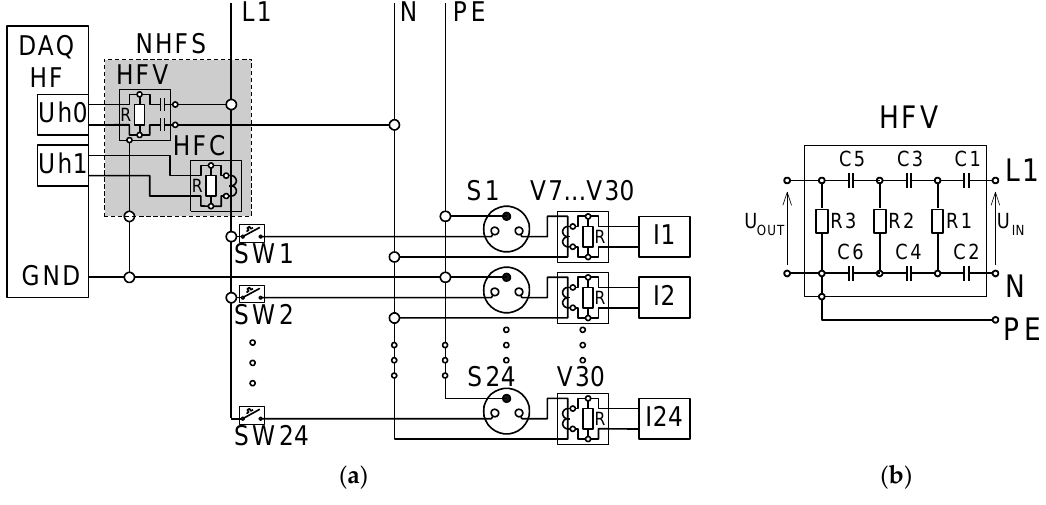
Figure 14. ( a ) Schematic diagram of the high-frequency voltage and current measurement setup; ( b ) schematic diagram of NIALM high-frequency voltage sensor (HFV).